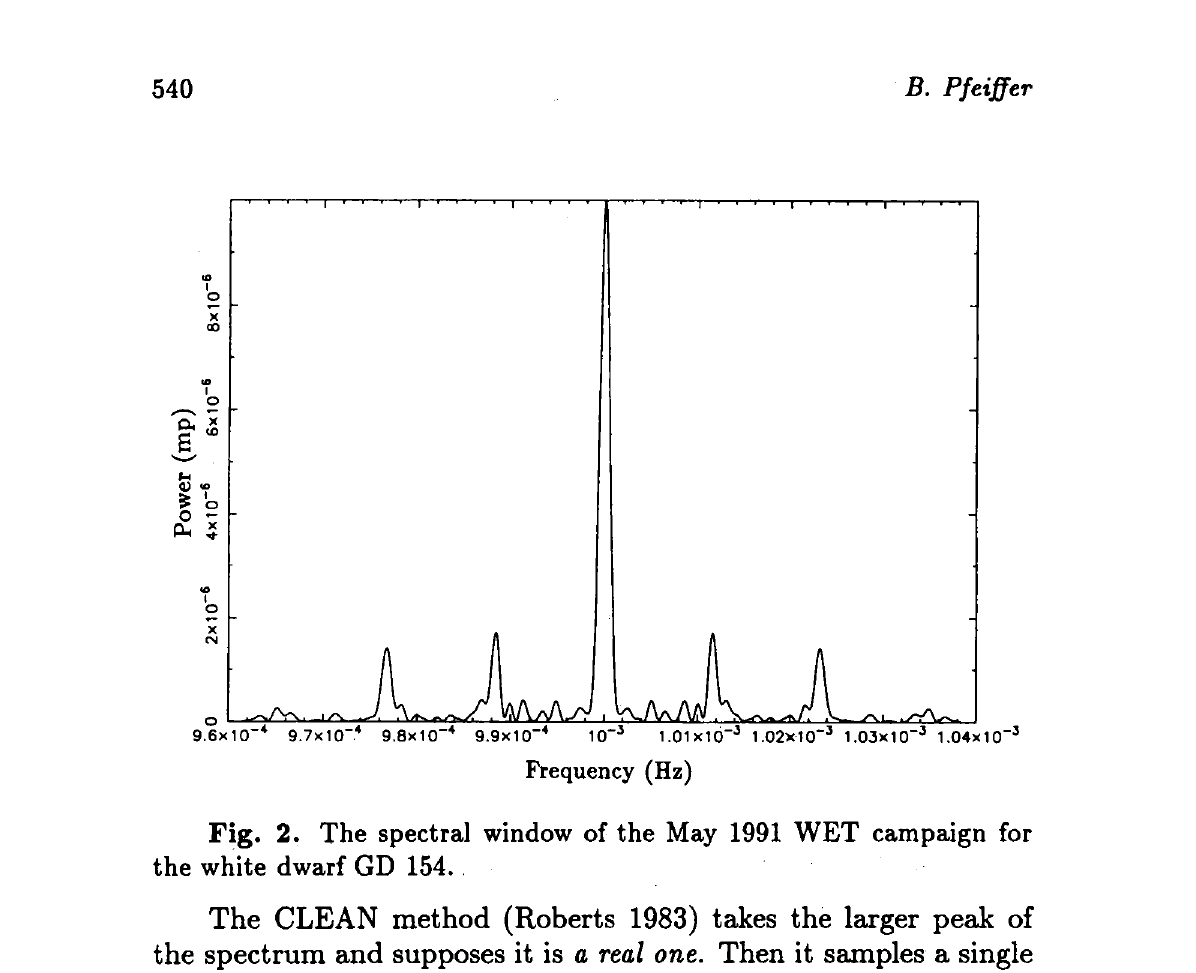
Fig. 2. The spectral window of the May 1991 WET campaign for the white dwarf GD